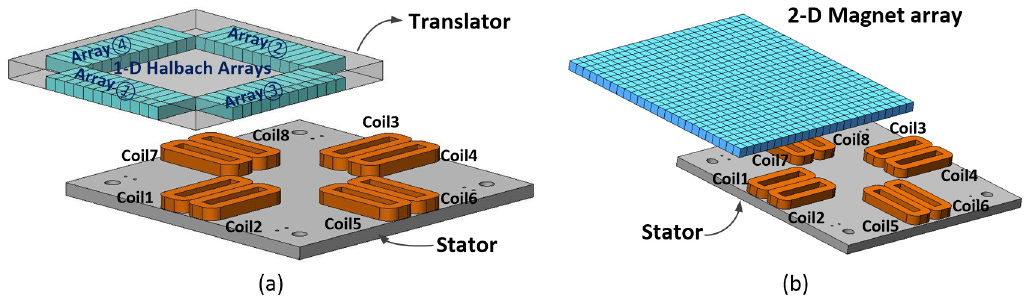
Figure 2. Two typical designs of the 6-DoF magnetically levitated actuator. ( a ) MLA based on the 1D Halbach array. ( b ) MLA based on the 2D magnetic